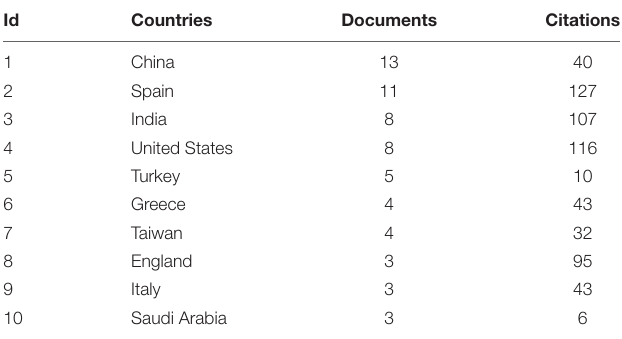
TABLE 4 | The top 10 productive countries from 2010 to 2021 (Documents ≥